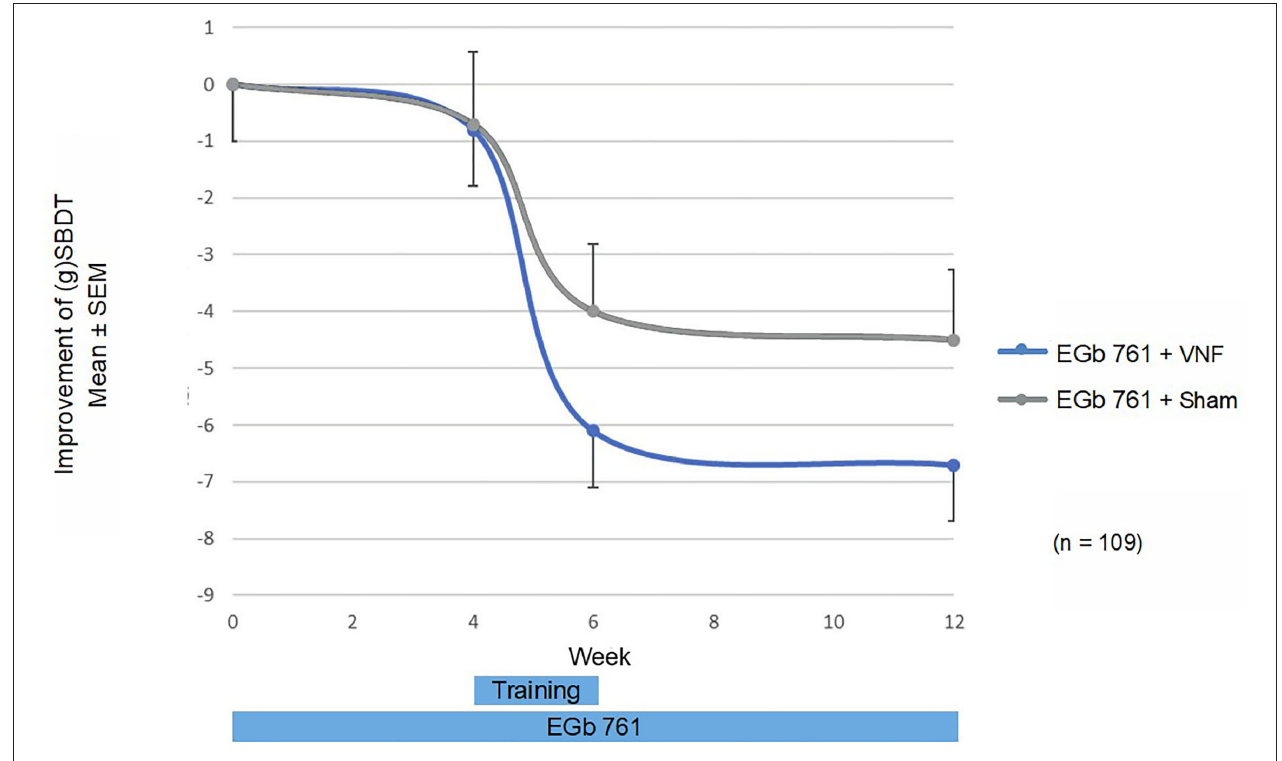
FIGURE 2 | gSBDT composite score: Change from baseline by visit and treatment